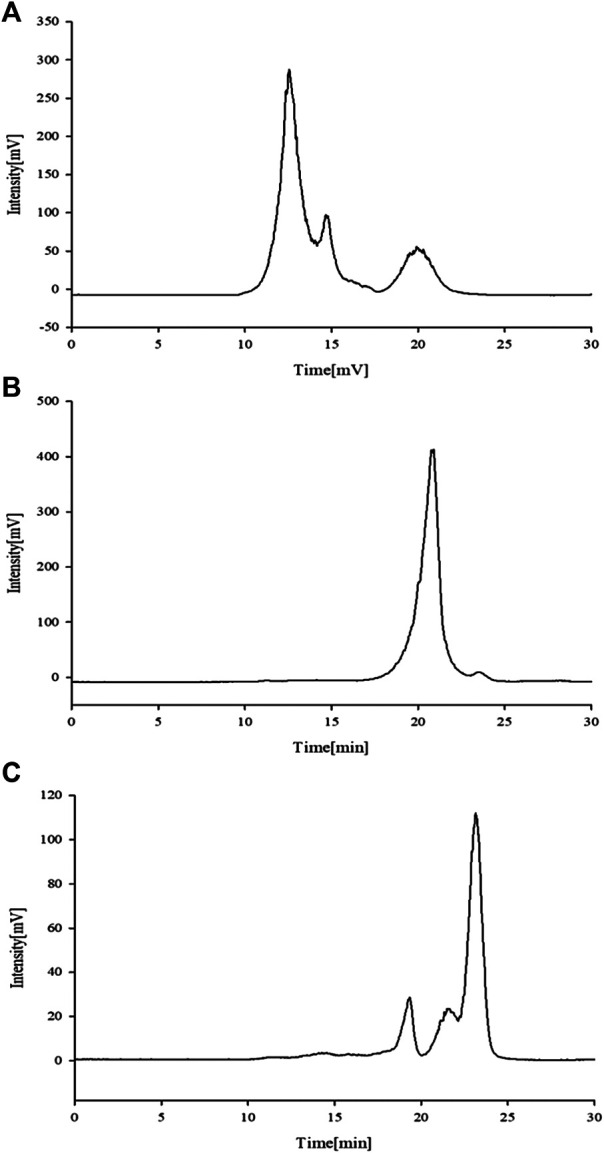
Chromatogram of APS-Ⅰ (A), APS-Ⅱ (B) and APS-Ⅲ (C) by HPLC-ELSD.